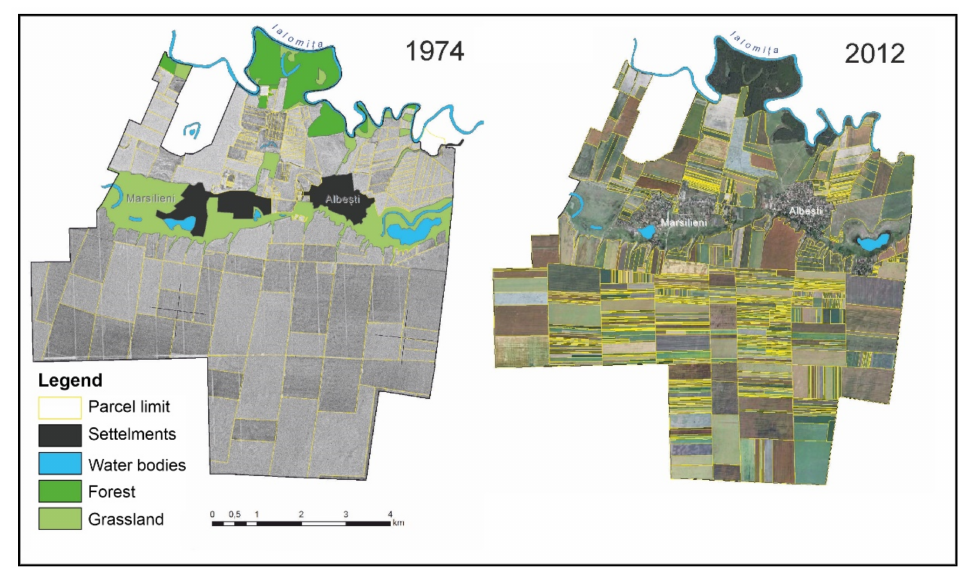
Figure 11. Land fragmentation in 1974 and 2012 (Albes